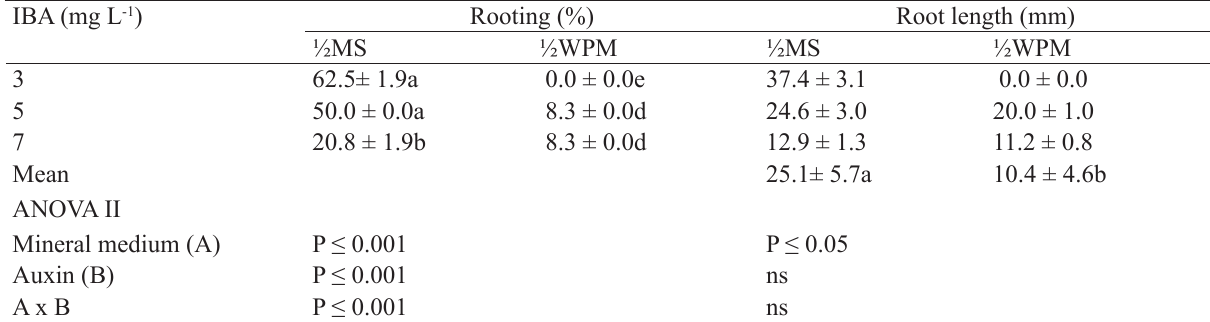
Table 2. Influence of auxin concentration and mineral medium on rooting rates of holm oak in vitro shoots, genotype BOA-5. In each treatment, columns represent means ± SE of 36 explants. Column means followed by different letters differ significantly at P =0.05 level, according to the least significant difference (LSD) or T3 Dunnett test. ns: not